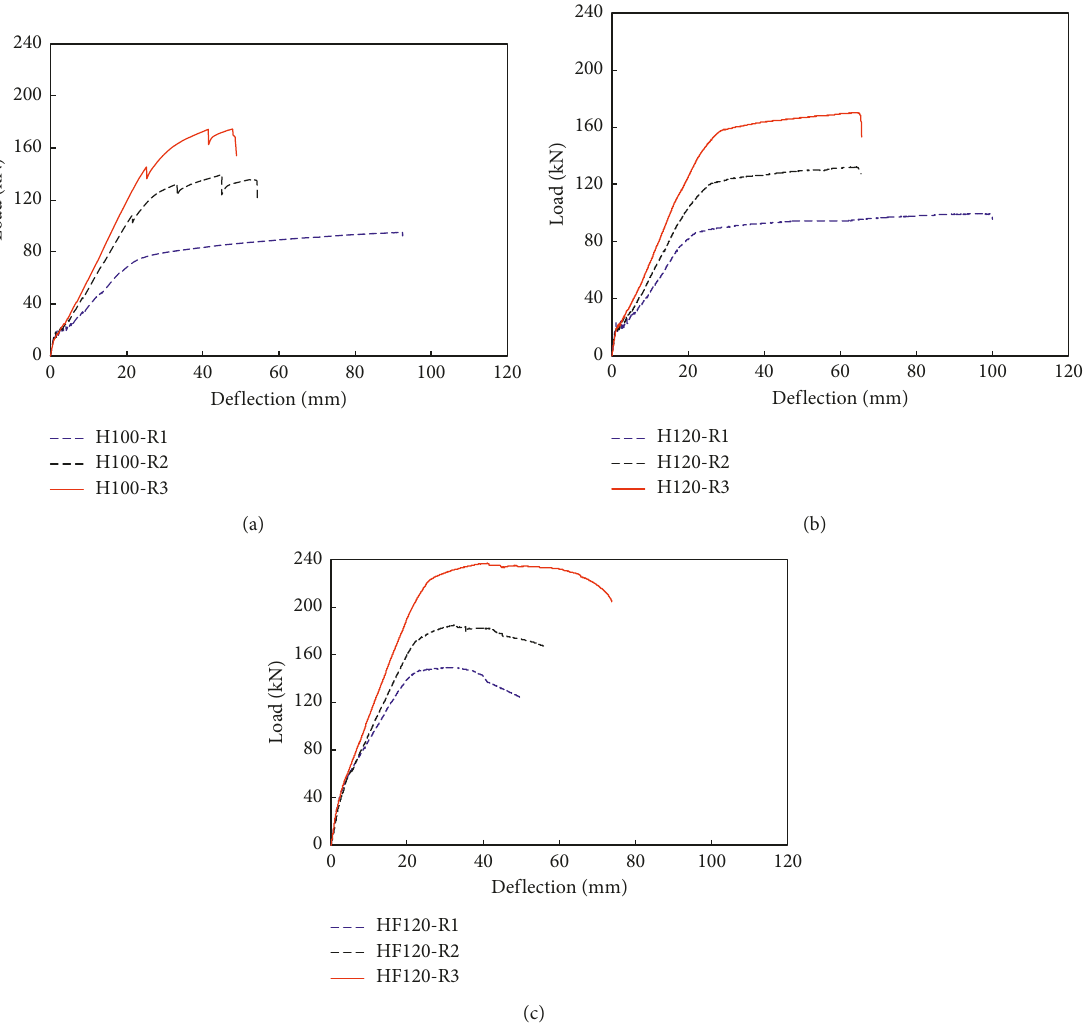
Figure 9(a). For the rebar ratio of 1.47% (R2), the de- flection at the failure of the HF120-R2 beam was similar to that of the two comparison beams, as shown in Figure 9(b).